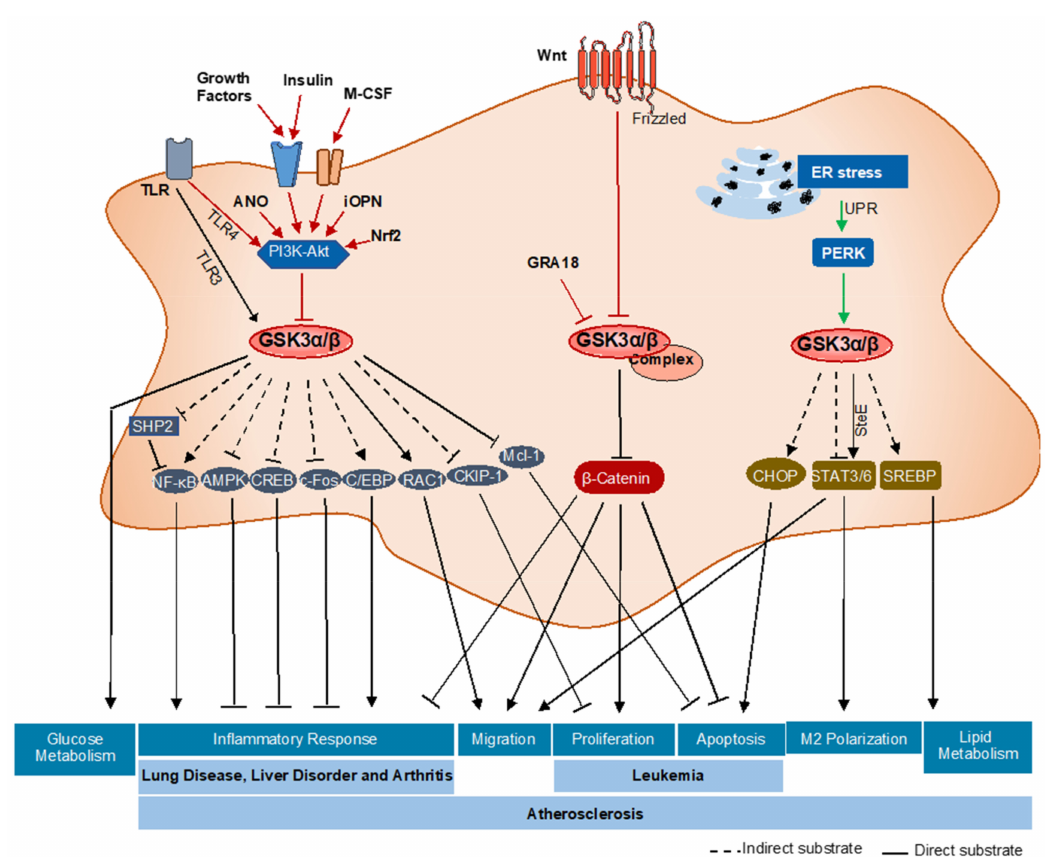
Figure 3. A summary of the GSK3 α / β signaling pathways in macrophage functions and related diseases. In macrophages GSK3 α / β can be activated or inactivated by different upstream signaling pathways. GSK3 α / β has a large number of downstream substrates that regulate a variety of different downstream signaling pathways to control macrophage phenotype and function. Dysregulation of one or more of these pathways has been implicated in the development of several different